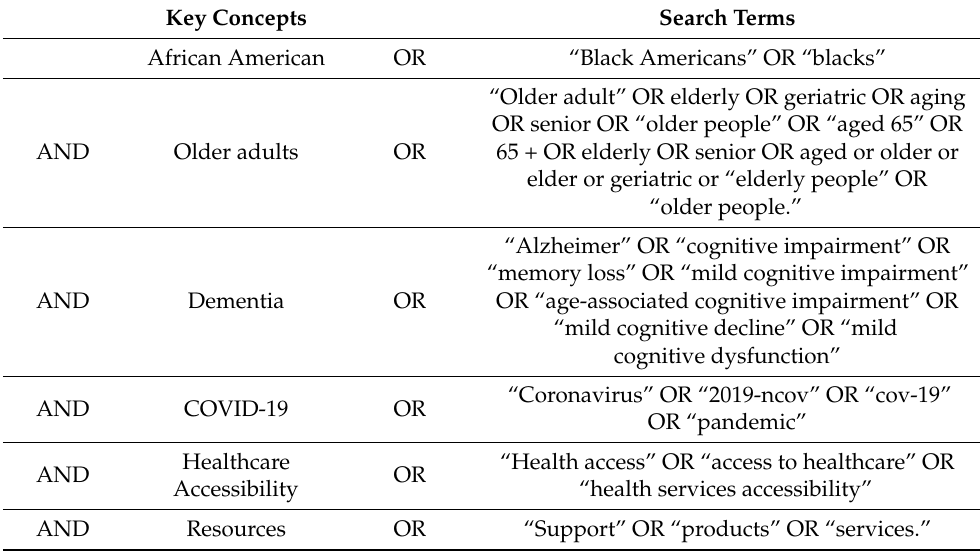
Table 1. Literature review key topics and search